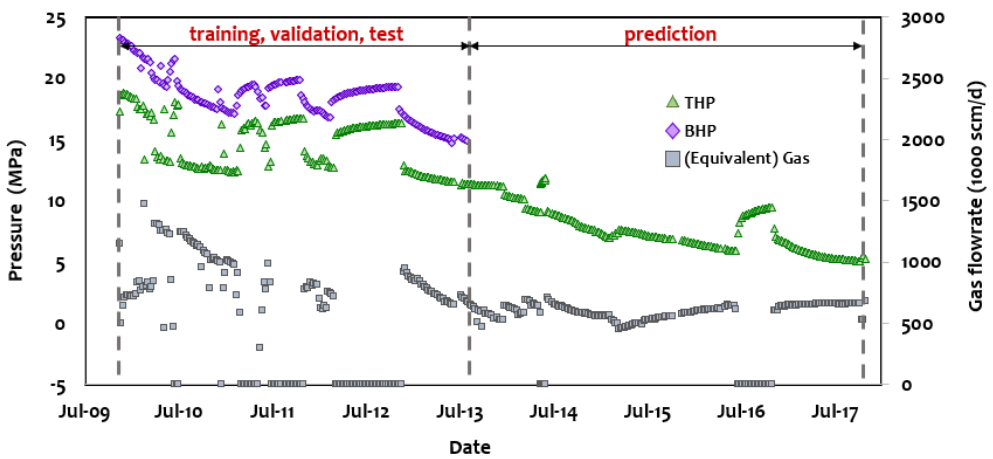
Figure 14. Revised dataset in Process 3.